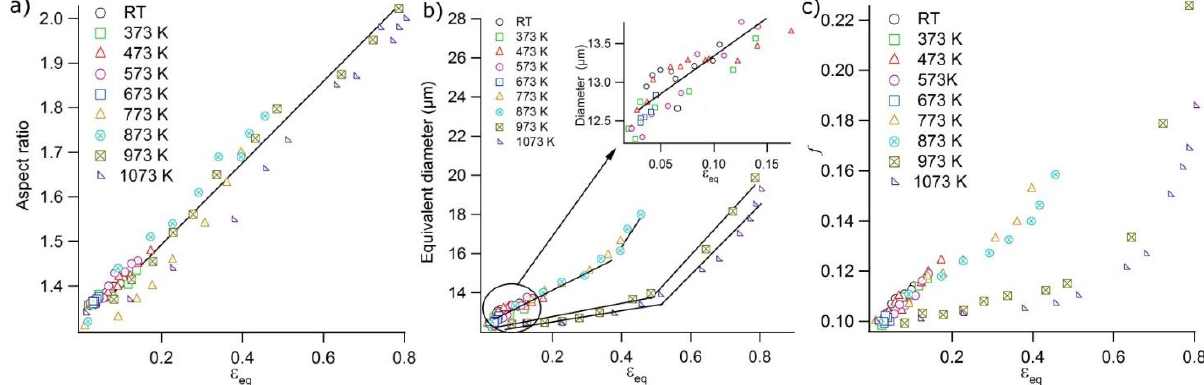
Figure 6. Evolution of ( a ) the aspect ratio, ( b ) the equivalent diameter of voids around graphite nodules and ( c ) the void area fraction as a function of the equivalent plastic strain ε eq , after tensile tests performed for temperatures ranging from RT to 1073 K (measurements in the longitudinal